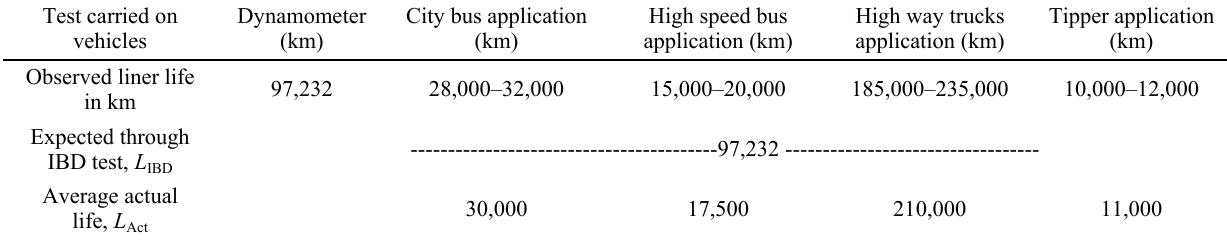
Table 1 Comparison of liner life expected through IBD wear test & the actual life of the liner L Act . Test carried on